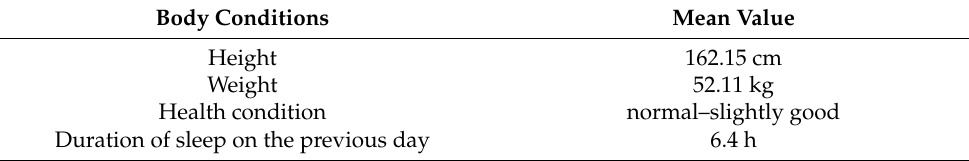
Table 6. Mean value of subjects.